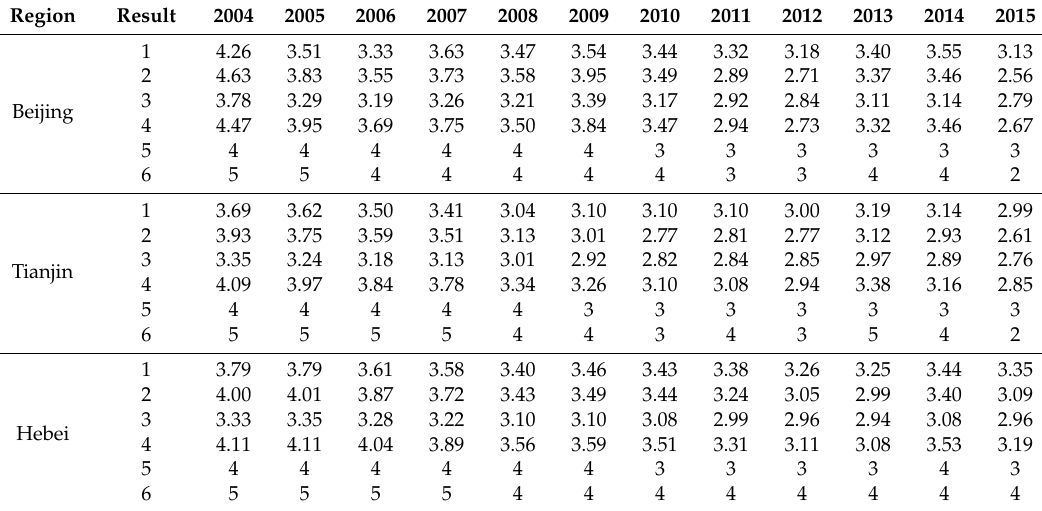
Table 9. Evaluation results of different methods